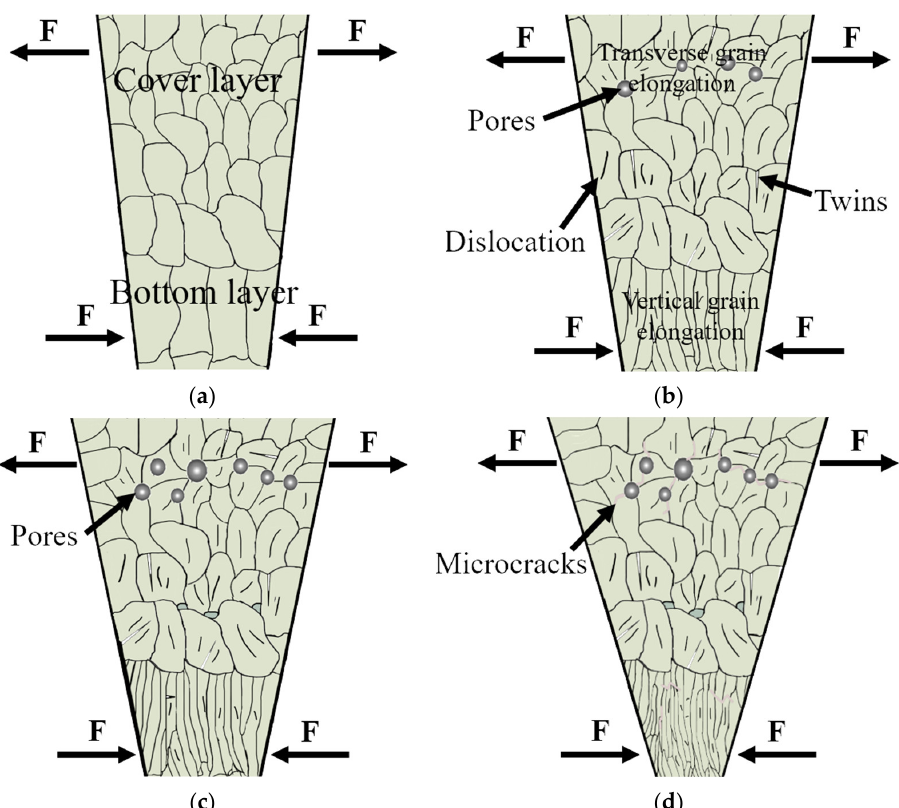
Figure 12. Schematic drawing of bending fracture mechanism of welded joint. ( a ) The microstructure of the welded joint at the bending start stage, ( b – d ) the microstructure of the welded joint during the bending test.